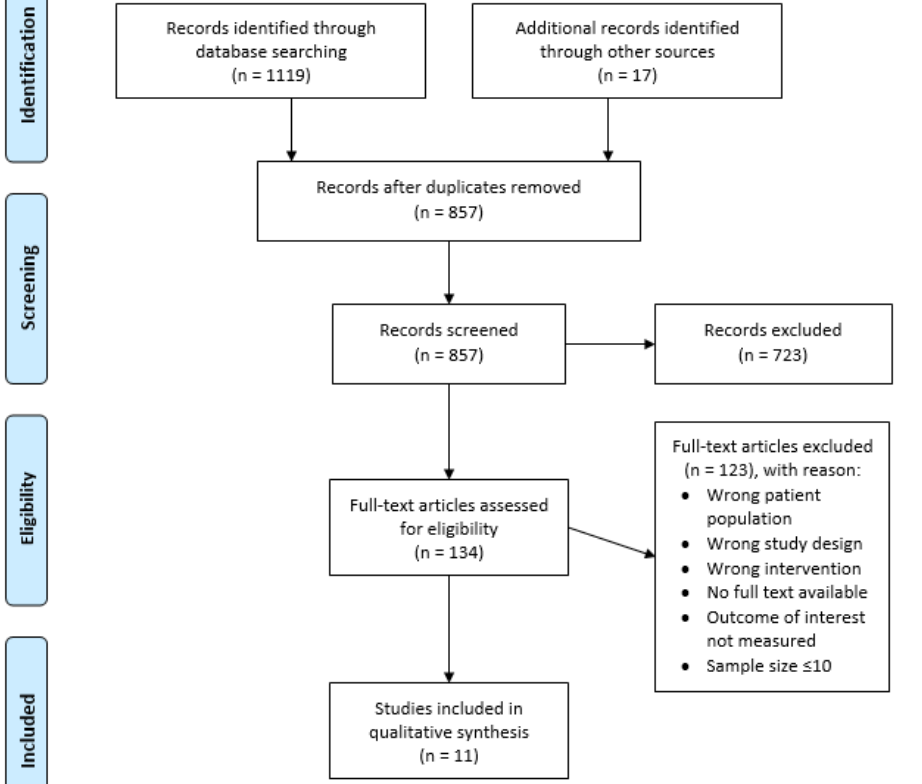
Figure 1. PRISMA flow diagram outlining the study selection process.